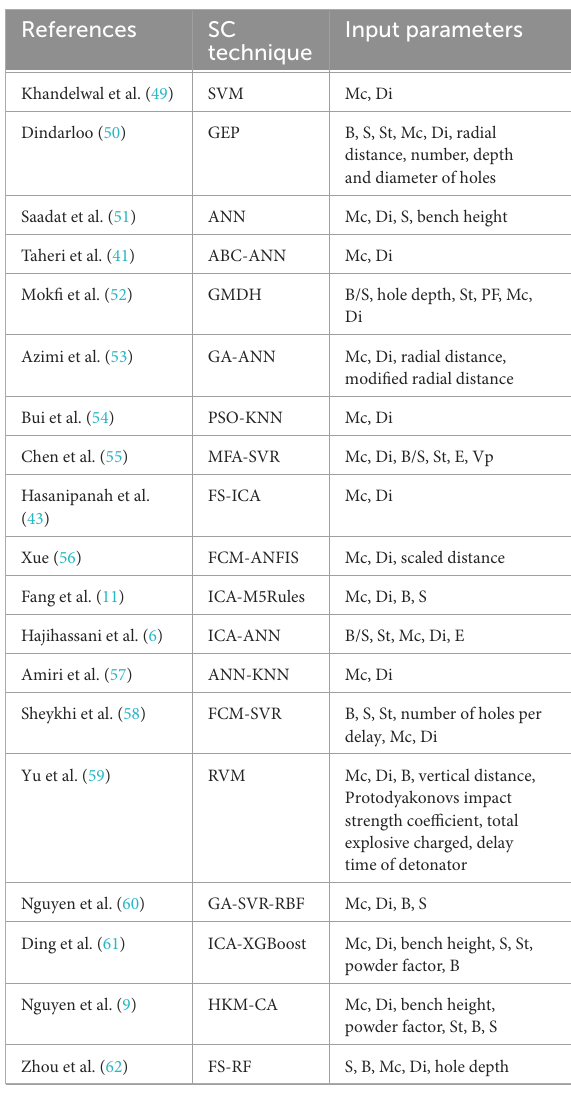
TABLE 1 Some studies in the field of PPV